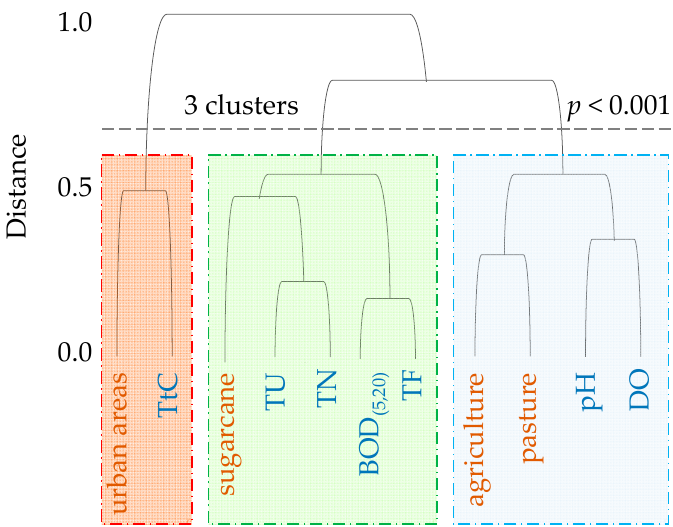
Figure 4. Association between land uses and water quality (Ward’s method).